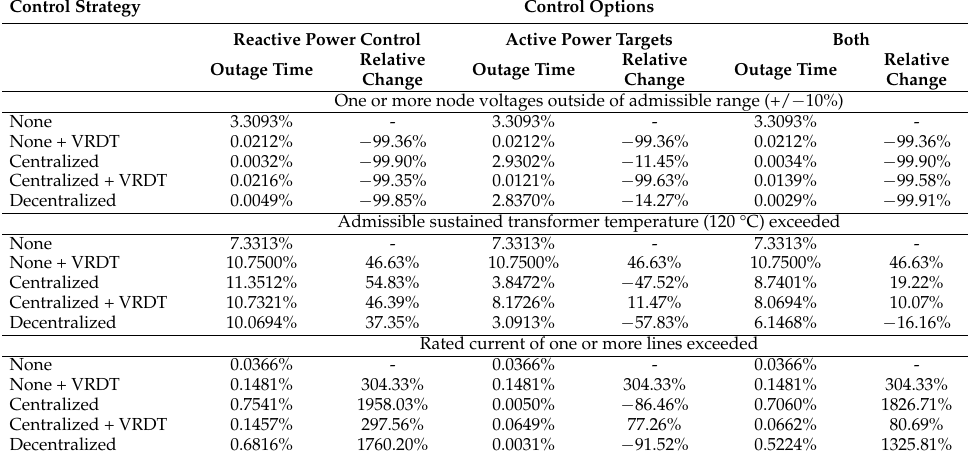
Table 5. An overview of the simulation results for all grid control strategies and options. The outage time corresponds to the percentage of time when one or more grid status variables are outside of the admissible range at one or more locations in the